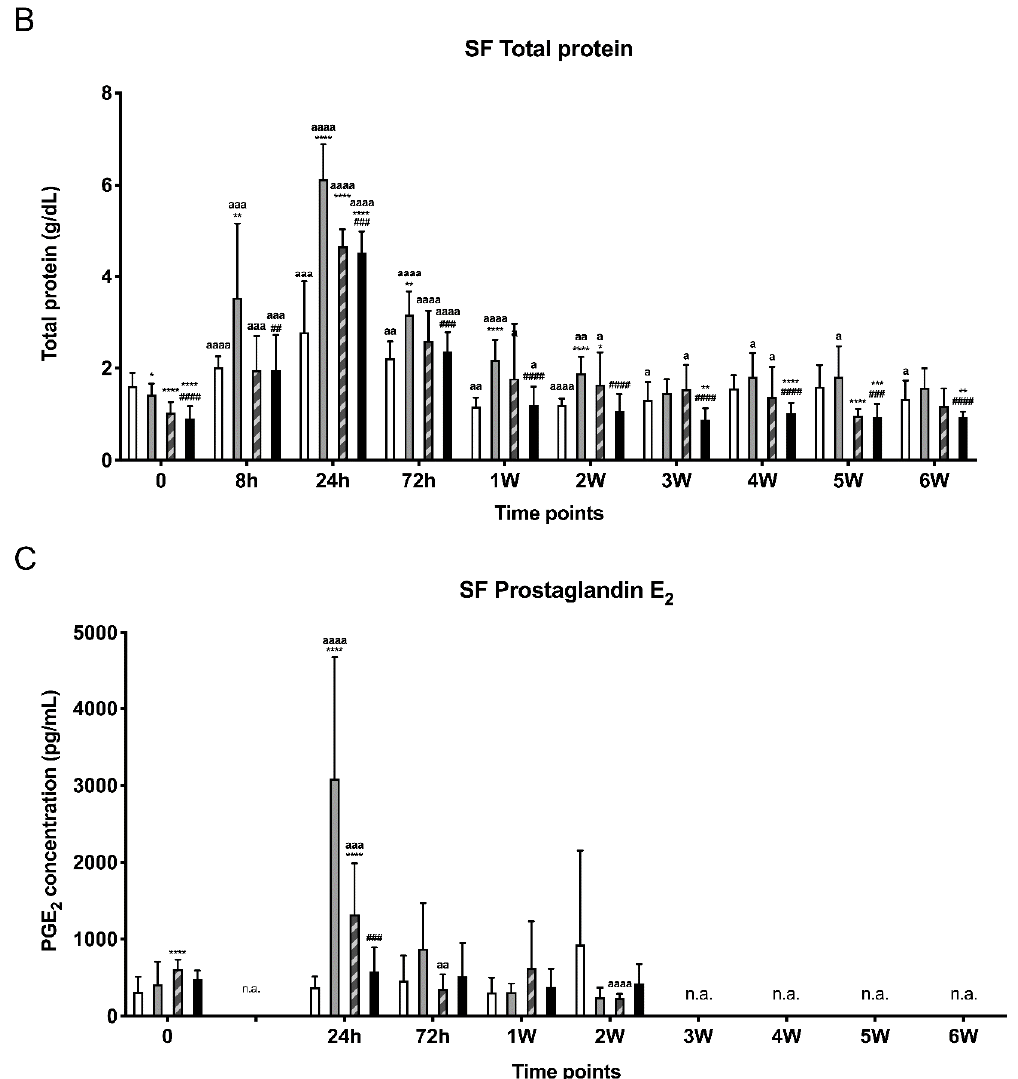
Figure 3. Synovial fluid concentrations of inflammatory parameters: WBC ( A ), TP ( B ), and PGE 2 ( C ). Graphs show the mean ± SD. Significant differences are depicted as follows: treatment groups vs. saline (*), unloaded vs. tacrolimus-loaded monospheres (#), or differences compared to the baseline within the same treatment group (a). One symbol: p > 0.01, two symbols: p < 0.01, three symbols: p < 0.001, and four symbols: p <